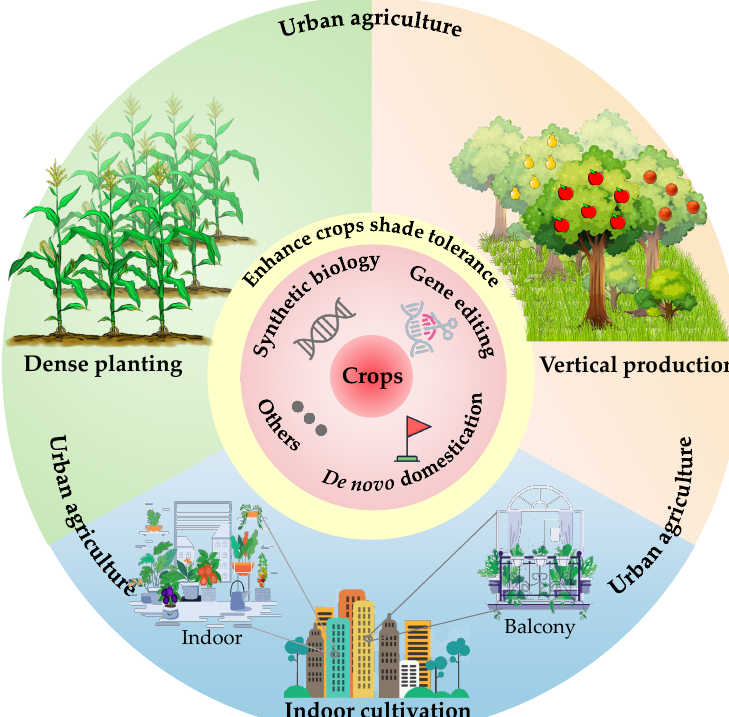
Figure 4. Application prospect of shade-tolerant plants in urban agriculture. To enable human society to keep pace with environmental change and population growth, more food needs to be produced in a limited space and under low-light conditions. Biotechnologies, such as gene editing, synthetic biology, and de novo domestication, help to accelerate the enhancement of crop shade tolerance, so as to adapt to dense planting, vertical production, and indoor cultivation, and their application to urban